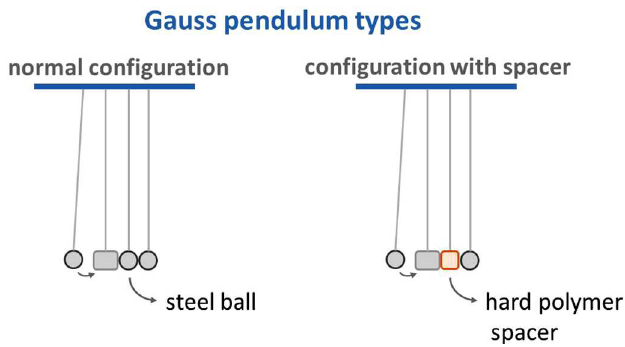
Fig. 4. Two distinct Gauss pendulum configurations tested in this work. The normal configuration uses a steel ball as a spacer, with the same functionality as the Gauss rifle depicted in Figure 1. The second configuration uses a hard polymer spacer instead of a steel ball. By doing so, we could easily manufacture several separators differing in